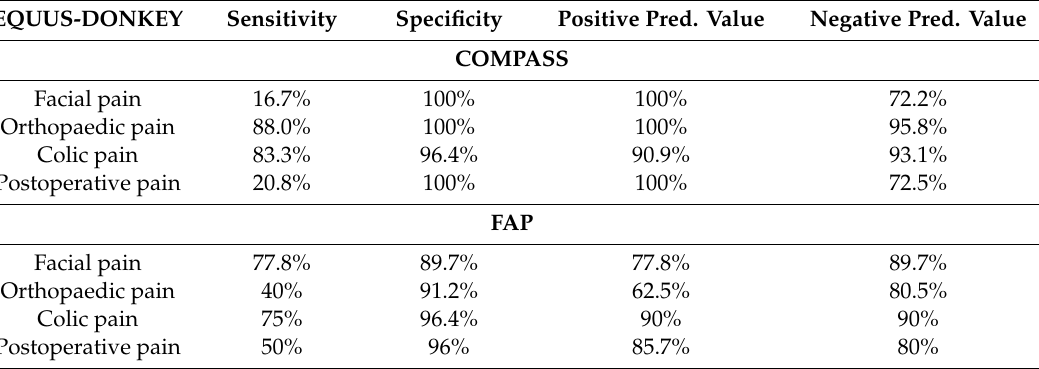
Table 4. Sensitivity, specificity, positive and negative predictive value of the EQUUS-DONKEY- COMPASS and the EQUUS-DONKEY-FAP for di ff erent types of pain.